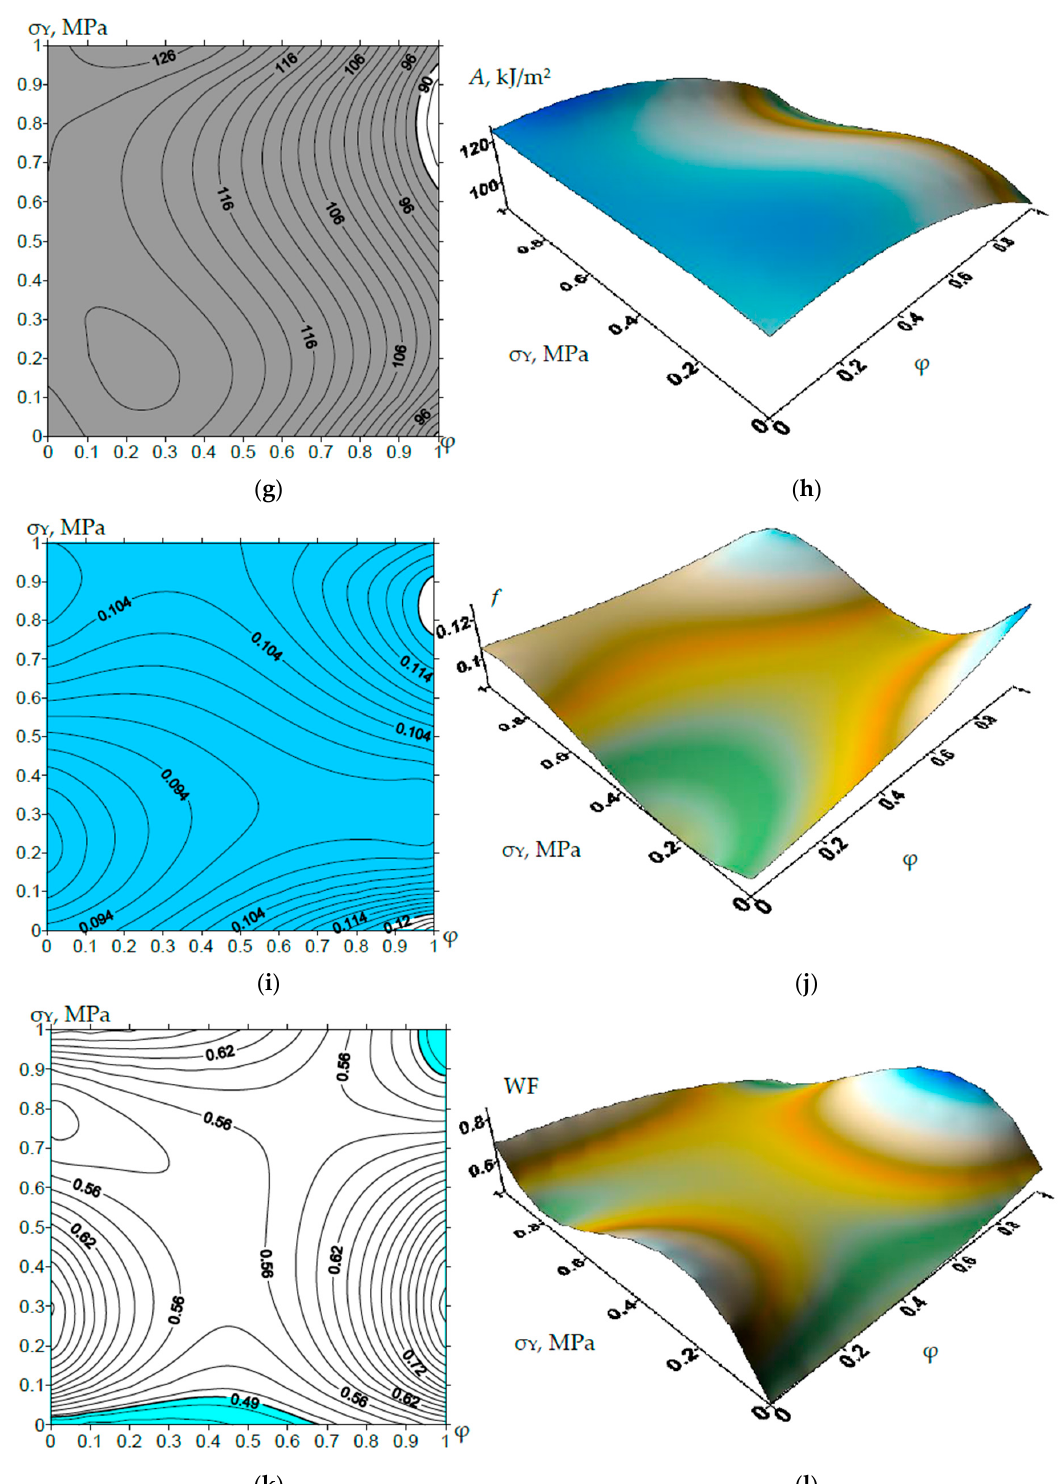
Figure 14. Isoline patterns on the operational properties of the UHMWPE-based composites: elastic modulus E , MPa ( a , b ); ultimate tensile strength σ U , MPa ( c , d ); elongation at break ε , % ( e , f ); impact toughness a k , kJ ∙ m ( g , h ); the friction coefficient f ( I , g ); and wear rate I, 10 − 6 mm 3 ∙ N − 1 ⋅ m − 1 (Load = 140 N, Velocity = 0.5 m ∙ s − 1 ) ( k , l ).